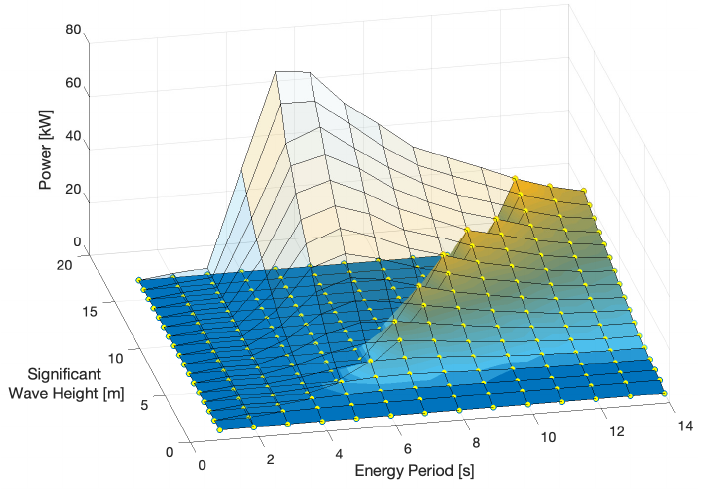
Figure 9. A three-dimensional map showing that the power distribution varies by sea